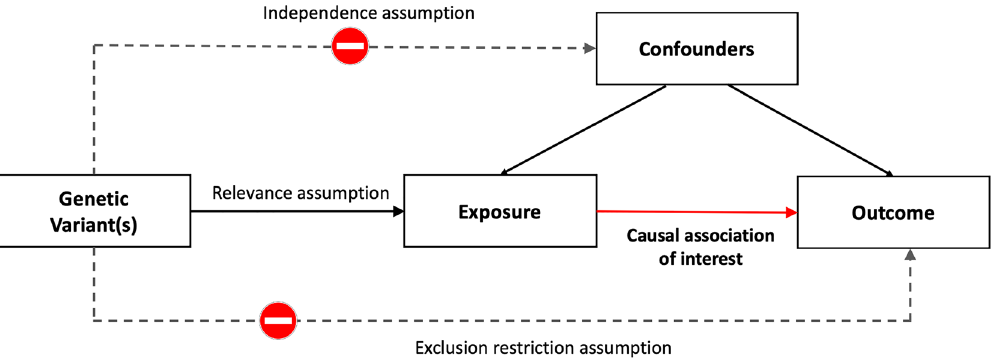
Figure 1. Conceptual illustration of the Mendelian Randomization (MR) method. The causal association of interest is between the exposure (e.g., physical activity) and the outcome (e.g., cognitive function). Relevance assumption states that the genetic instruments are strongly associated with the exposure but are not associated with the confounders. The exclusion restriction assumption states that the genetic instruments are only indirectly associated with the outcome via the exposure. Thus, the solid paths are expected to exist, while the dashed paths are expected to be nonsignificant according to the core MR